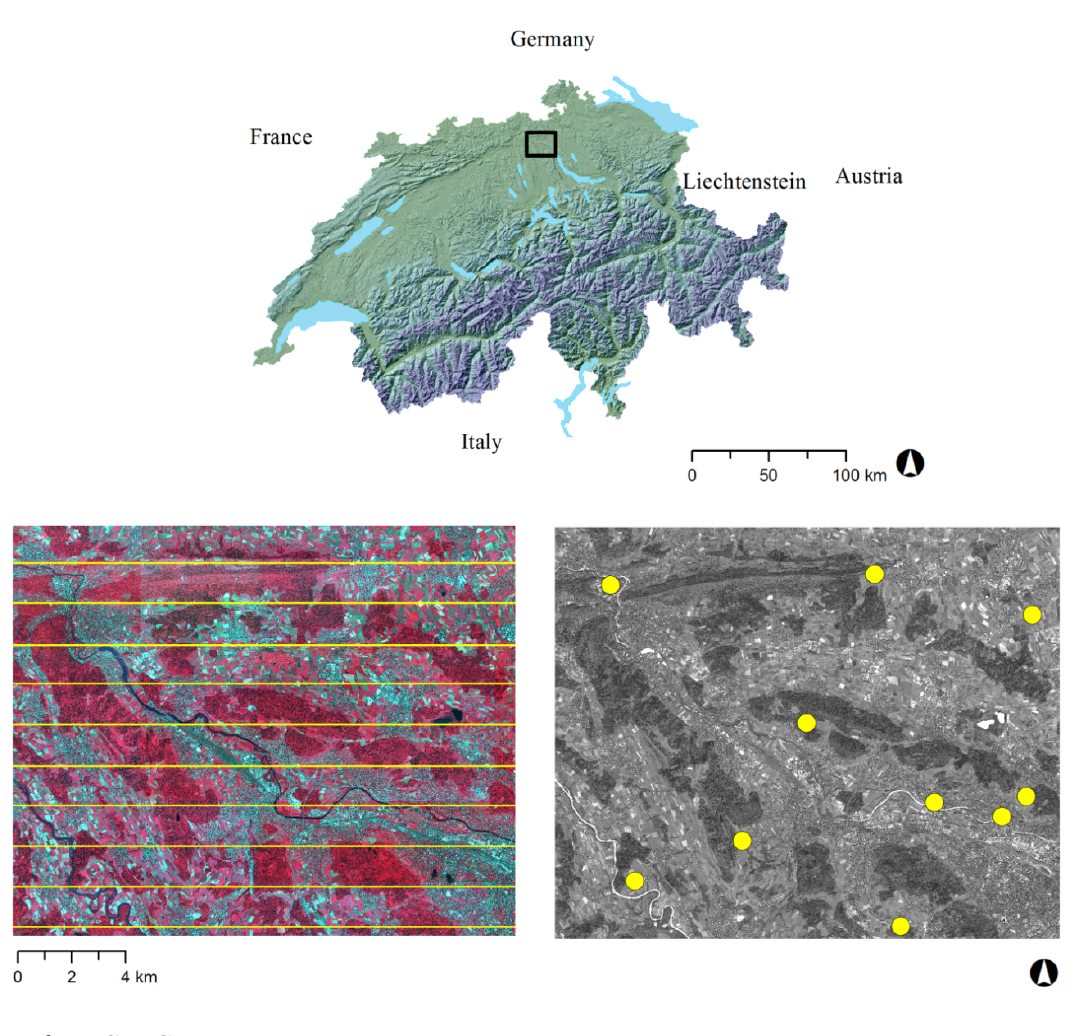
Figure 1. Location of the study area in Switzerland between the cities of Zurich and Baden (top, black rectangle). ADS80 CIR image with 11 centrelines of the stripes with 50% overlap in yellow (bottom left) and WorldView-2 scene with the 10 ground control points (GCPs) for orientation enhancing in yellow (bottom